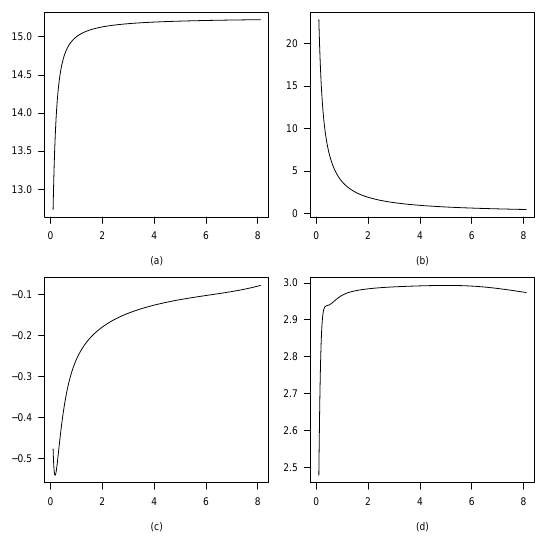
Figure 12 – Mean, in panel (a), variance, in panel (b), skewness, in panel (c), kurtosis, in panel (d), ( θ , α ) } , for m = 20, θ = 0.75, and α > of the intermediate binomial distributions { q i